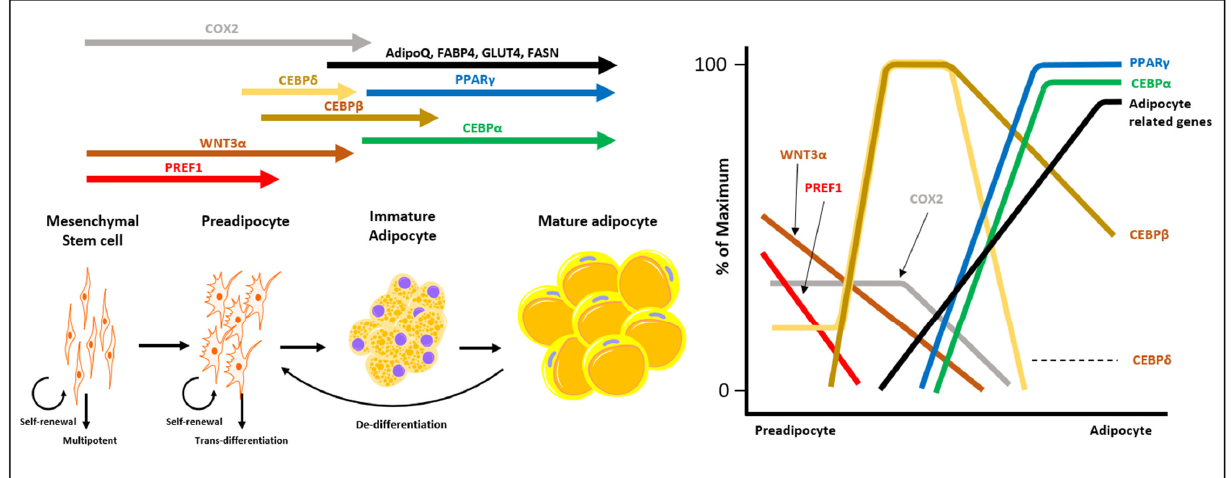
Figure 2. Alteration of gene expression during adipocyte differentiation. Differentially expressed genes throughout the adipocyte lineage are illustrated according to the timeframe. Mesenchymal stem cells exhibit the highest proliferative and pluripotent capacity, which decreases during adipocyte differentiation. Adipocyte dedifferentiation involves the loss of mature adipocyte markers, such as PPAR γ and CEBP α , while acquiring the mesenchymal stem cell phenotype. Abbreviations: COX-2, cyclooxygenase-2; AdipoQ, adiponectin; FABP4, fatty acid binding protein 4; GLUT4, glu- cose transporter type 4; FASN, fatty acid synthase; CEBP α , CCAAT/enhancer binding protein α